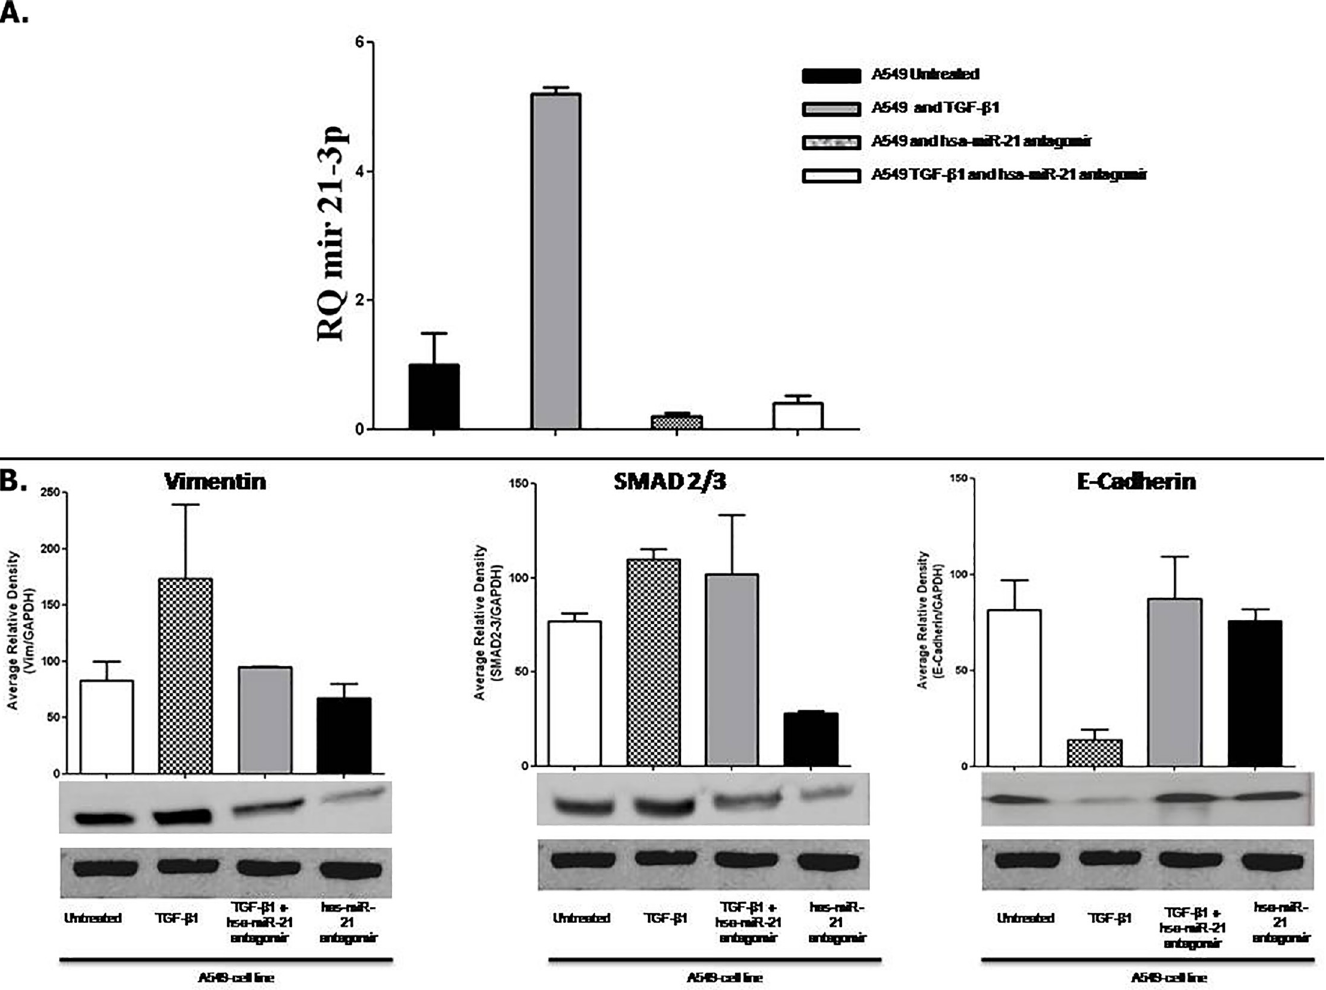
Fig 6. (A) Relative expression of hsa-mir-21-3p. The data showed a down-regulation of has-miRna in A549 cells treated with TGF- β 1 plus hsa-miR-21 antagomir and hsa-miR-21 antagomir alone, compareted to A549 cells with TGF- β 1 alone. (B) EMT characterization of A549 treated with TGF- β 1 by Western Blot analyses. The data showed the over-expression of Vimentin and SMAD 2/3 and the down regulation of E-Cadhern in A549 cell line treated with TGF- β 1. The results showed a reversion of Vimentin and SMAD 2/3 to basal level after treatment with hsa-miR-21 antagomir. S3 Fig. Blot images presented in the manuscript uncropped and unadjusted in the Fig